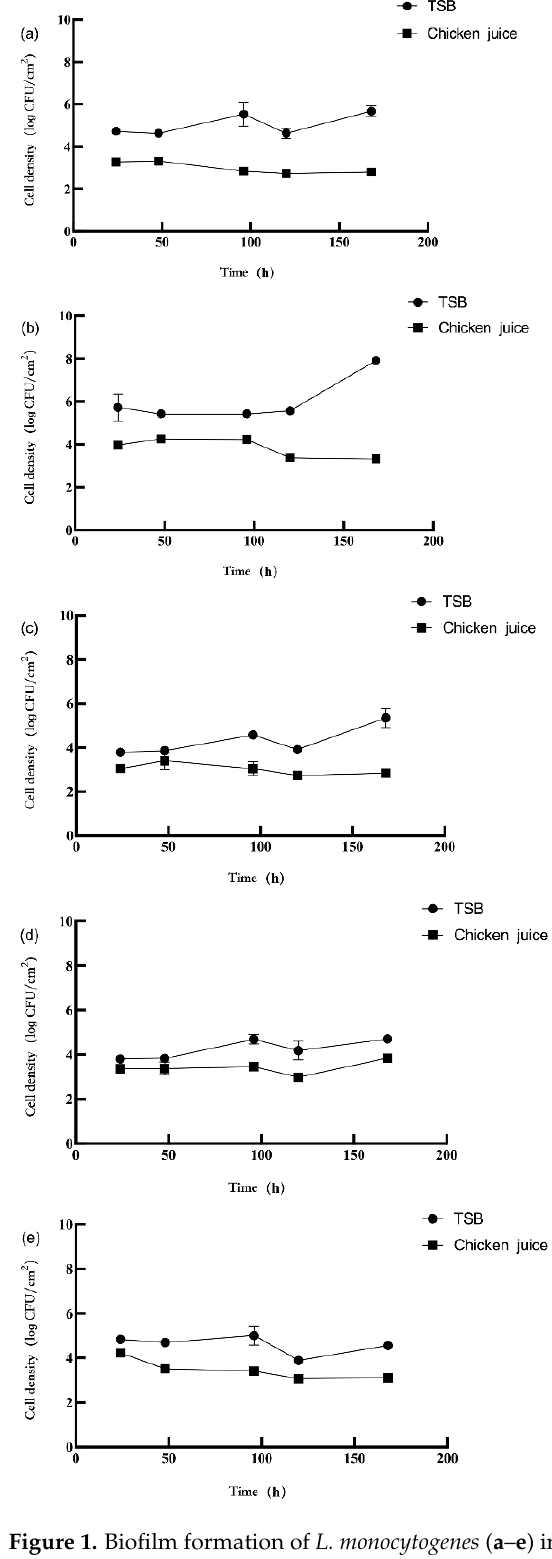
Figure 1. Biofilm formation of L. monocytogenes ( a – e ) in different incubation conditions. Note: The mono-species biofilms of L. monocytogenes with the initial inoculum concentration of 3 log CFU/mL ( a ) and 4 log CFU/mL ( b ); the dual-species biofilms of L. monocytogenes and P. aeruginosa with the ratio 1:1 ( c ); 1:10 ( d ); and 10:1 ( e ).